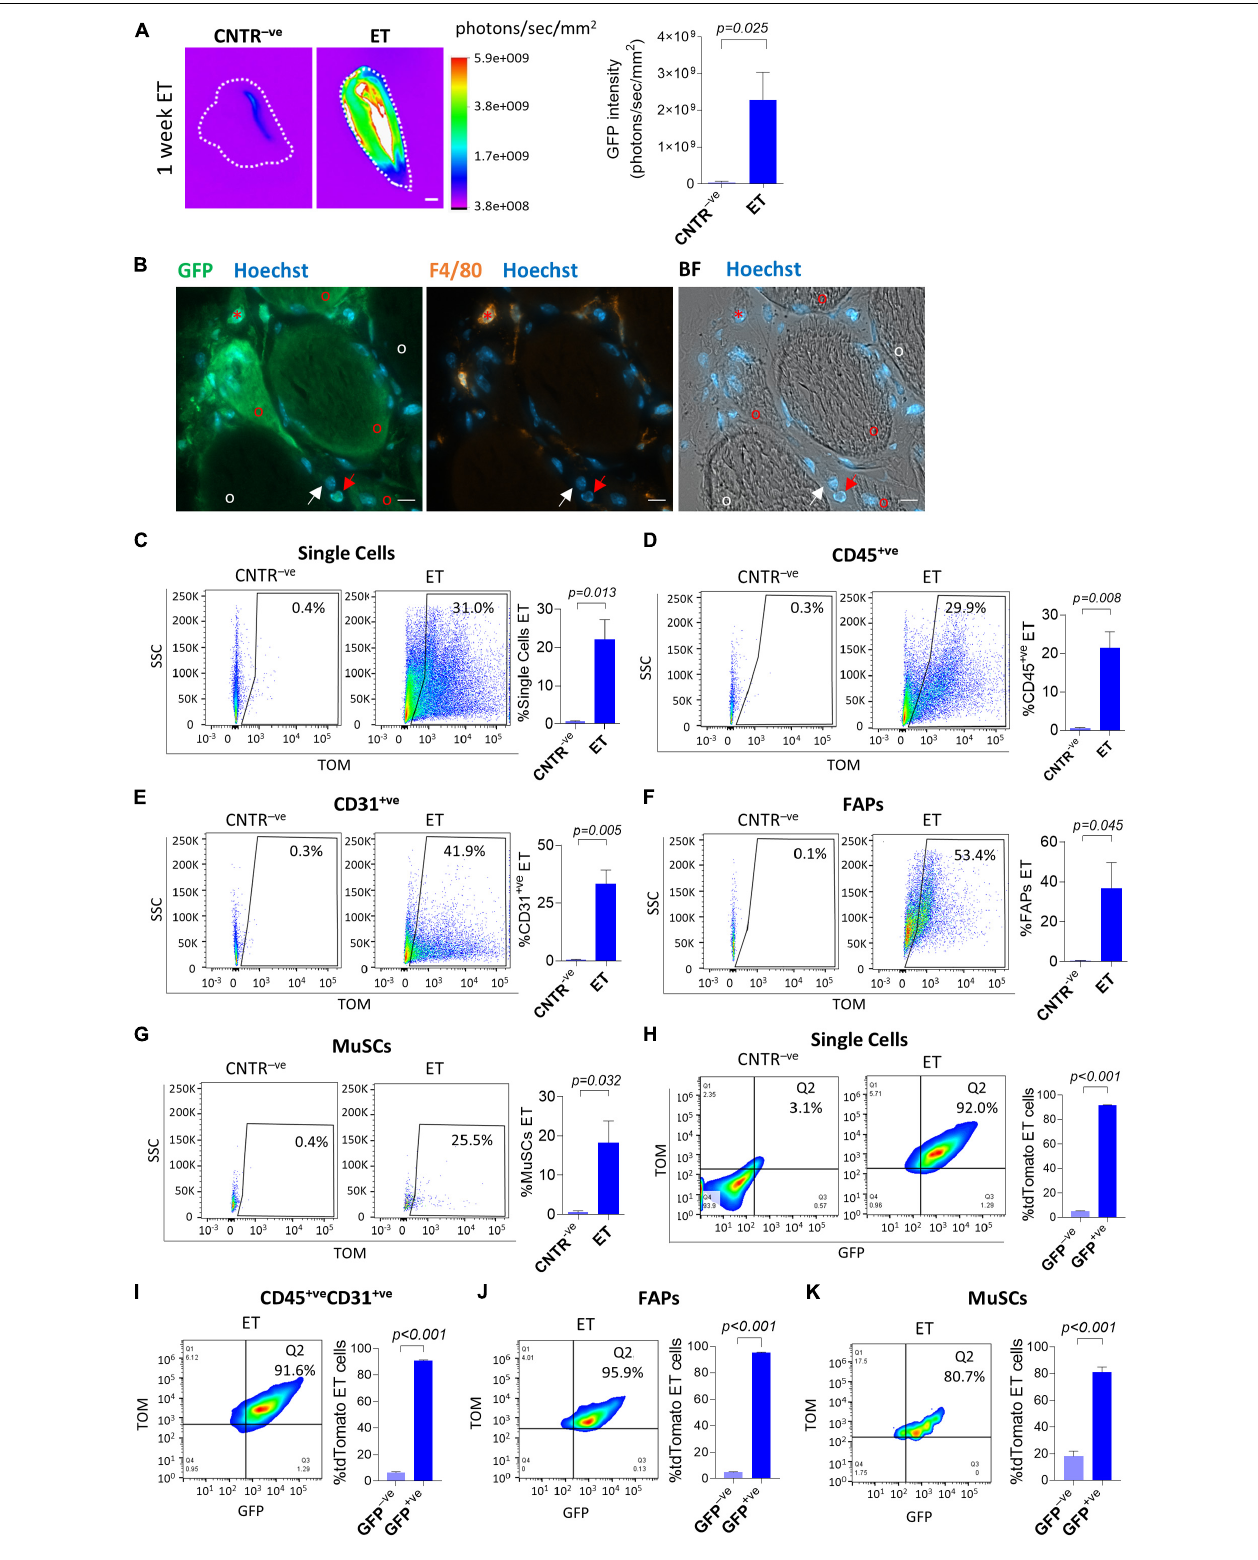
FIGURE 1 | In vivo electroporation of whole muscles and single cells. (A) GFP intensity measurement (photons/sec/mm 2 ) of whole gastrocnemius (CNTR – ve ) or TA (ET) from ∼ 12 months-old C57BL/6J mice injected with GFP plasmid and electroporated (ET) or not injected nor electroporated (CNTR – ve ). Scale bar: 2.5